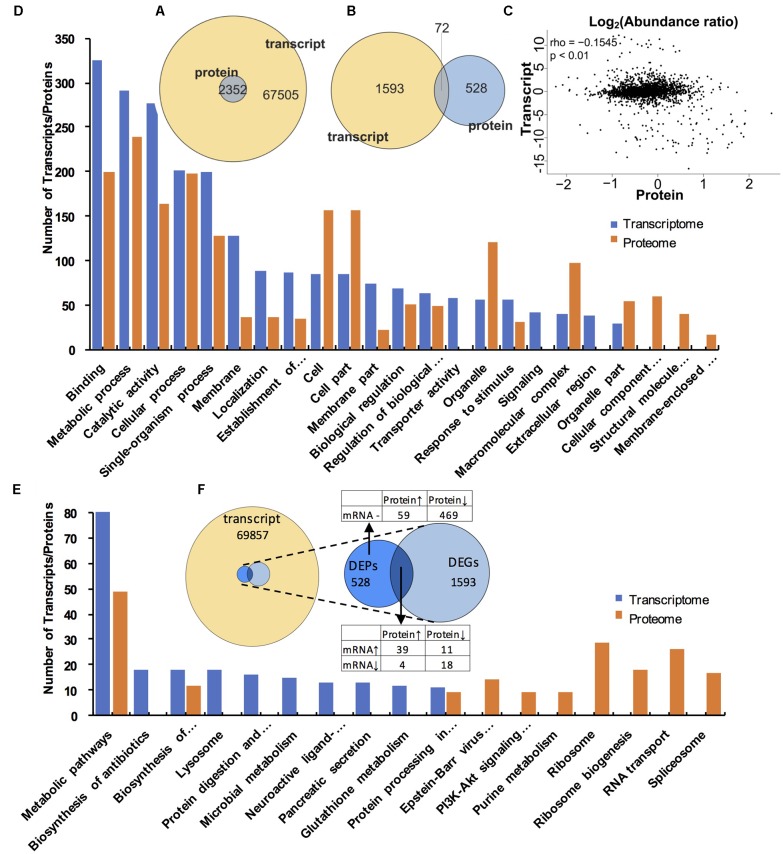
Comparative analysis of proteomic and transcriptomic data. (A) Venn diagrams of all transcripts and proteins. The image represents all transcripts and proteins. (B) Venn diagrams of DEGs and DEPs. The circle of different colors represents the different omics data of the same sample, yellow represents the transcript, and the blue represents the protein, where the values represent the common and specific transcripts and proteins in the same sample, and the sum of all the numbers within the circle represents the number of transcripts and proteins. The rounded region of the circle represents the number of DEGs and DEPs shared by the two groups. (C) The correlation scatter diagram of the expression of all proteins and their associated transcripts. The x-axis shows the mean value of the expressed protein in the group, and the y-axis indicates the mean value of the FPKM of the transcript in the same group. The expression of the transcript and the protein is taken as the logarithmic value. Each point represents a protein and its associated transcripts, rho in the legend represents the pearson correlation coefficient, p is the correlation test p-value. when rho > 0, it is called negative correlation; rho < 0, said positive correlation; rho = 0, called zero correlation, that is, no correlation; | rho| larger, the greater the correlation between the two groups. (D) The top 20 GO terms that contain the largest number of transcripts/proteins. Blue column indicates the transcripts in the transcriptome, orange column represents the proteins in the proteome. (E) The top 20 KEGG pathways that contains the largest number of transcripts/proteins. Blue column indicates the transcripts in the transcriptome, orange column represents the protein in the proteome. (F). Venn diagram showing relevance relation between DEPs and DEGs.